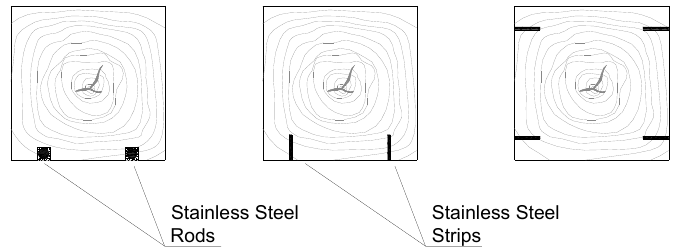
Figure 24. Examples of flexural reinforcement using bonded-in stainless steel rods or strips.